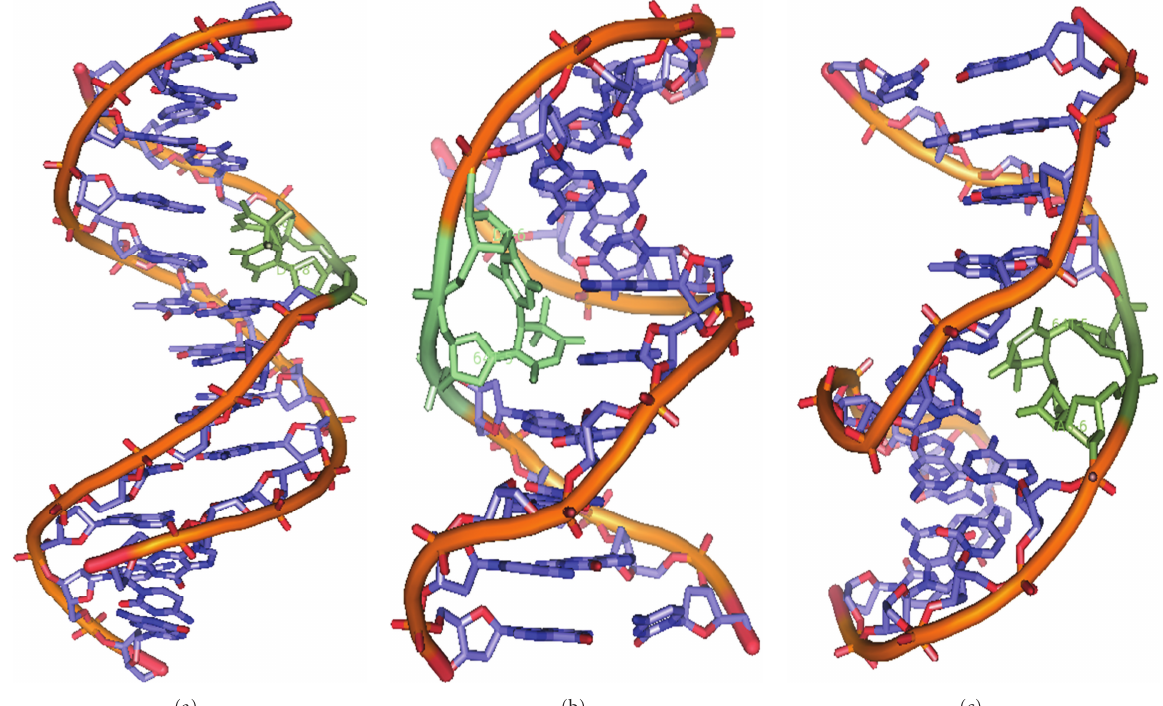
Figure 2: Structures of DNA duplexes showing the presence of lesions (in green) such as CPD (a), 6-4PP (b), and 6-4 Dewar dimer (c). Hydrogen atoms are not shown, prepared from PDB entries 1TTD [24], 1CFL [25], and 1QKG [26] using PyMol. (version 1.1r1)